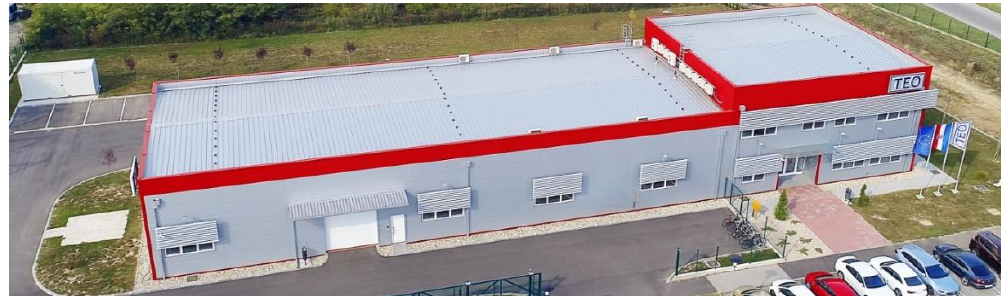
Figure 6. Test building in Valpovo, Croatia.